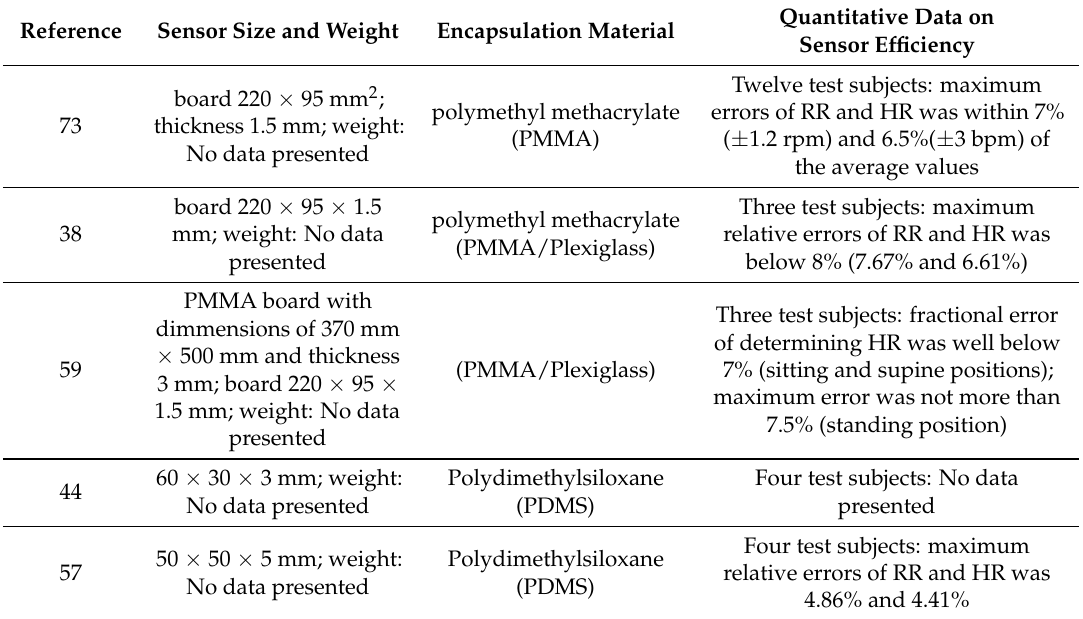
Table 1. A comparison of the most interesting prior works about fiber Bragg grating sensors tested in the real MR